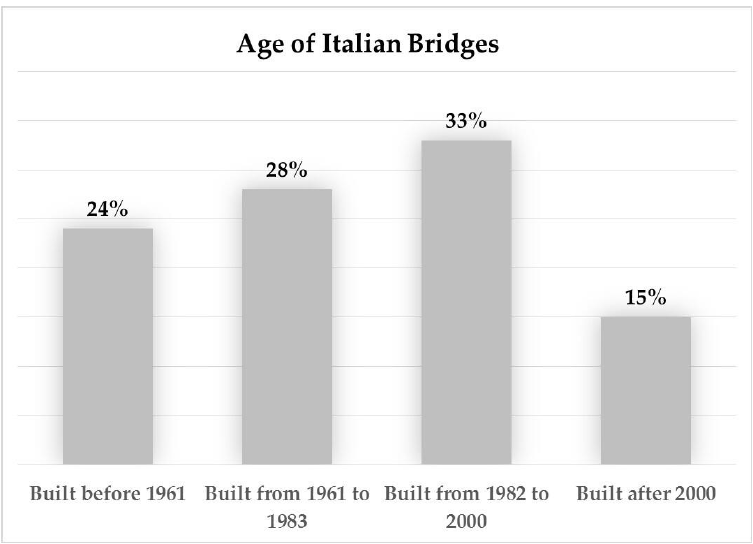
Figure 1. Age of Italian bridges.